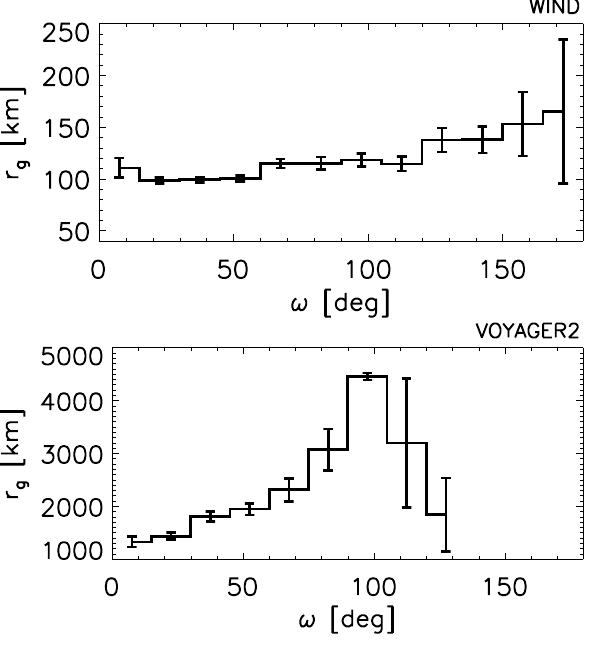
Fig. 17. Distribution of the mean r g over the DD over ω for Wind (top) and Voyager 2 (bottom); mean error is given by the error bars.